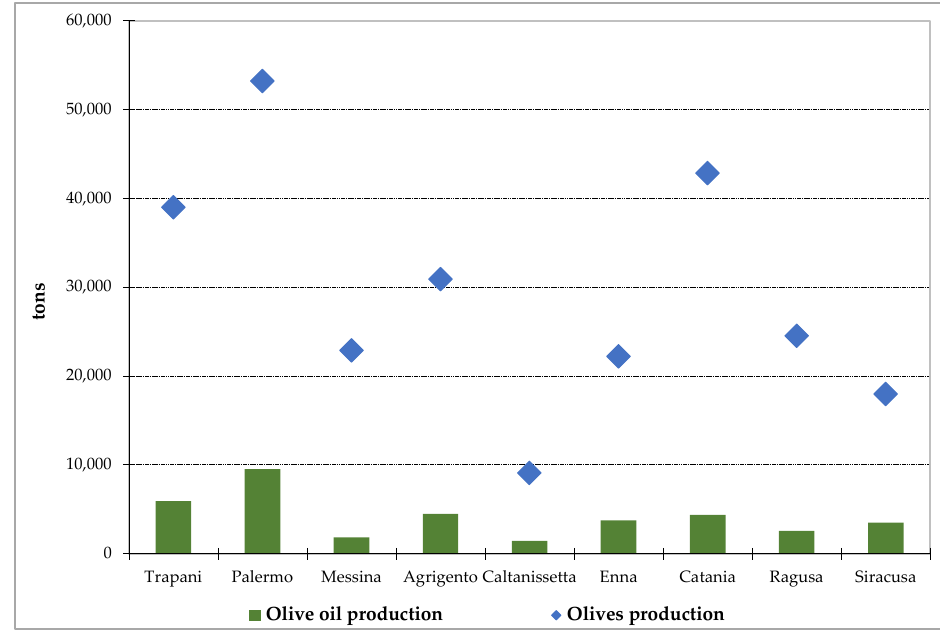
Figure 2. Olive production and olive oil production in Sicily (2019).